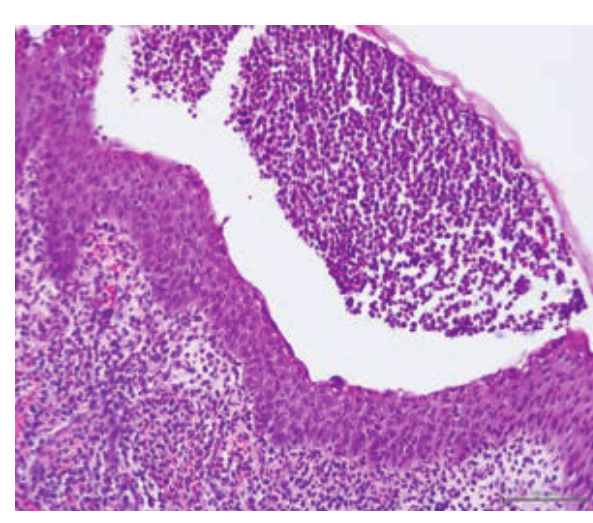
Figure 1. Photos of skin lesions. Photo shows a few varicella-like eruptions on the face (A) in association with numerous red papules of various sizes on the abdomen (B).